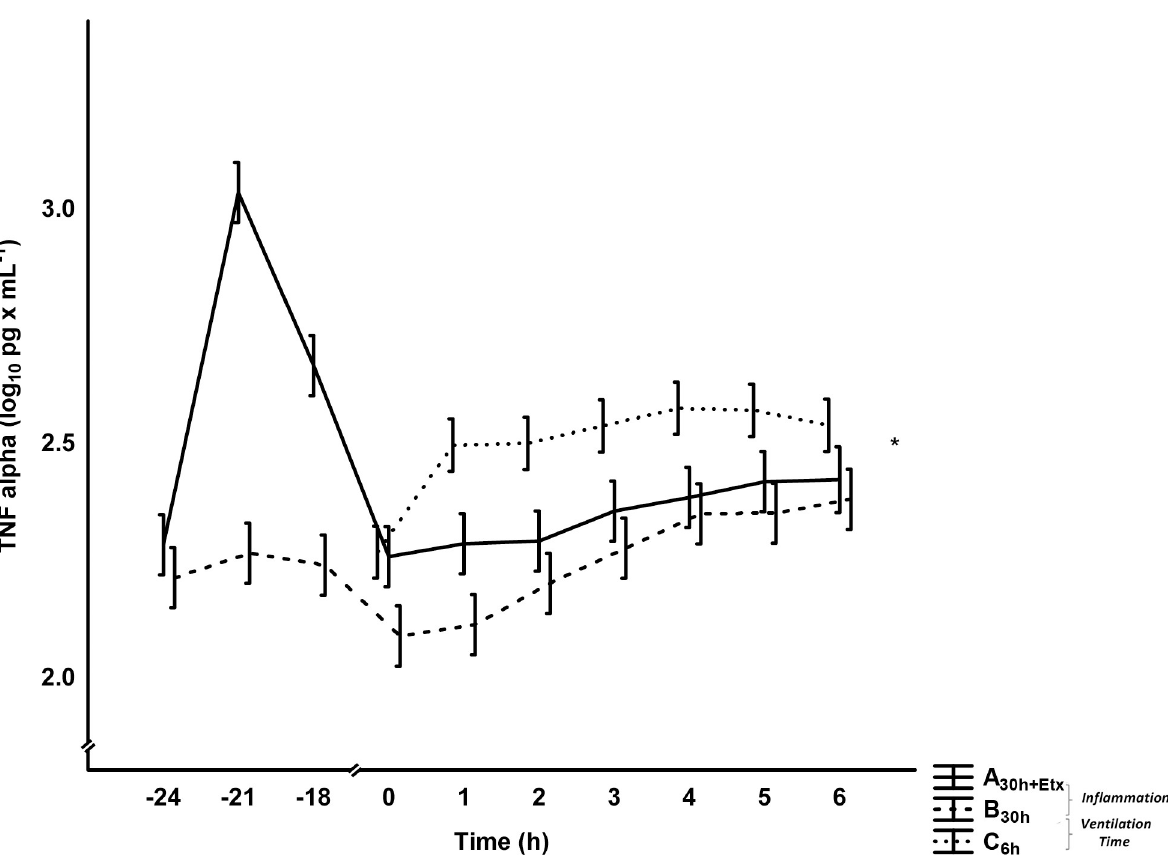
Fig 4. TNF- α in plasma. Mean ± SEM, total group difference calculated between 0–6 h with ANOVA for repeated measures, experimental parts Inflammation A 30h+Etx vs. B 30h , Ventilation Time B 30h vs. C 6h , � denotes p < 0.01 in Ventilation Time , axis scale changes at 0 hours.